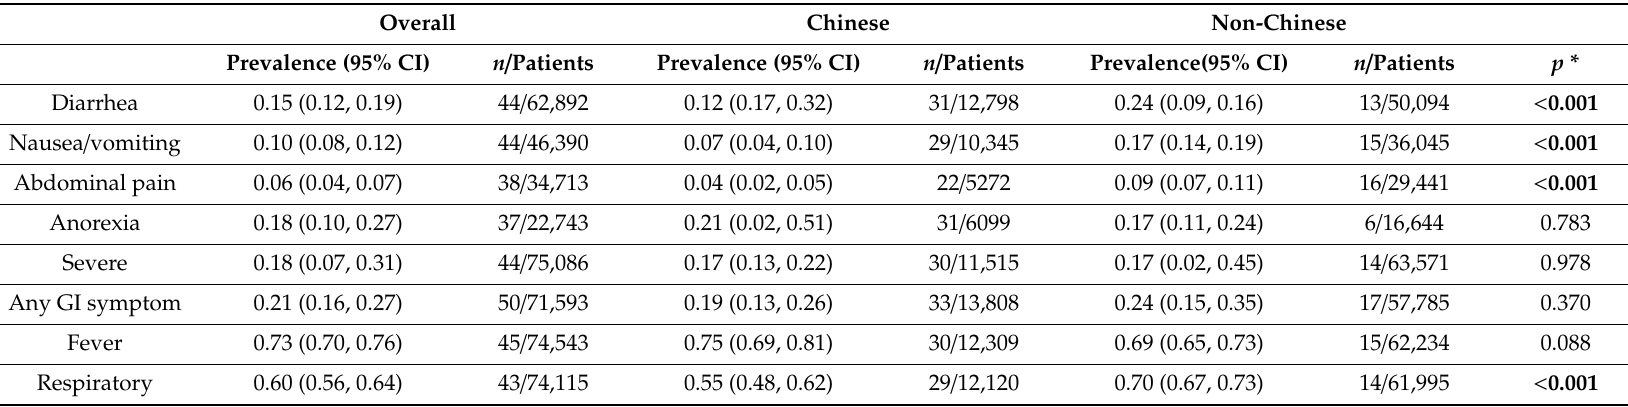
Table 2. Summary of the pooled prevalence estimates of gastrointestinal symptoms with respect to whether the study took place in China or out of China.